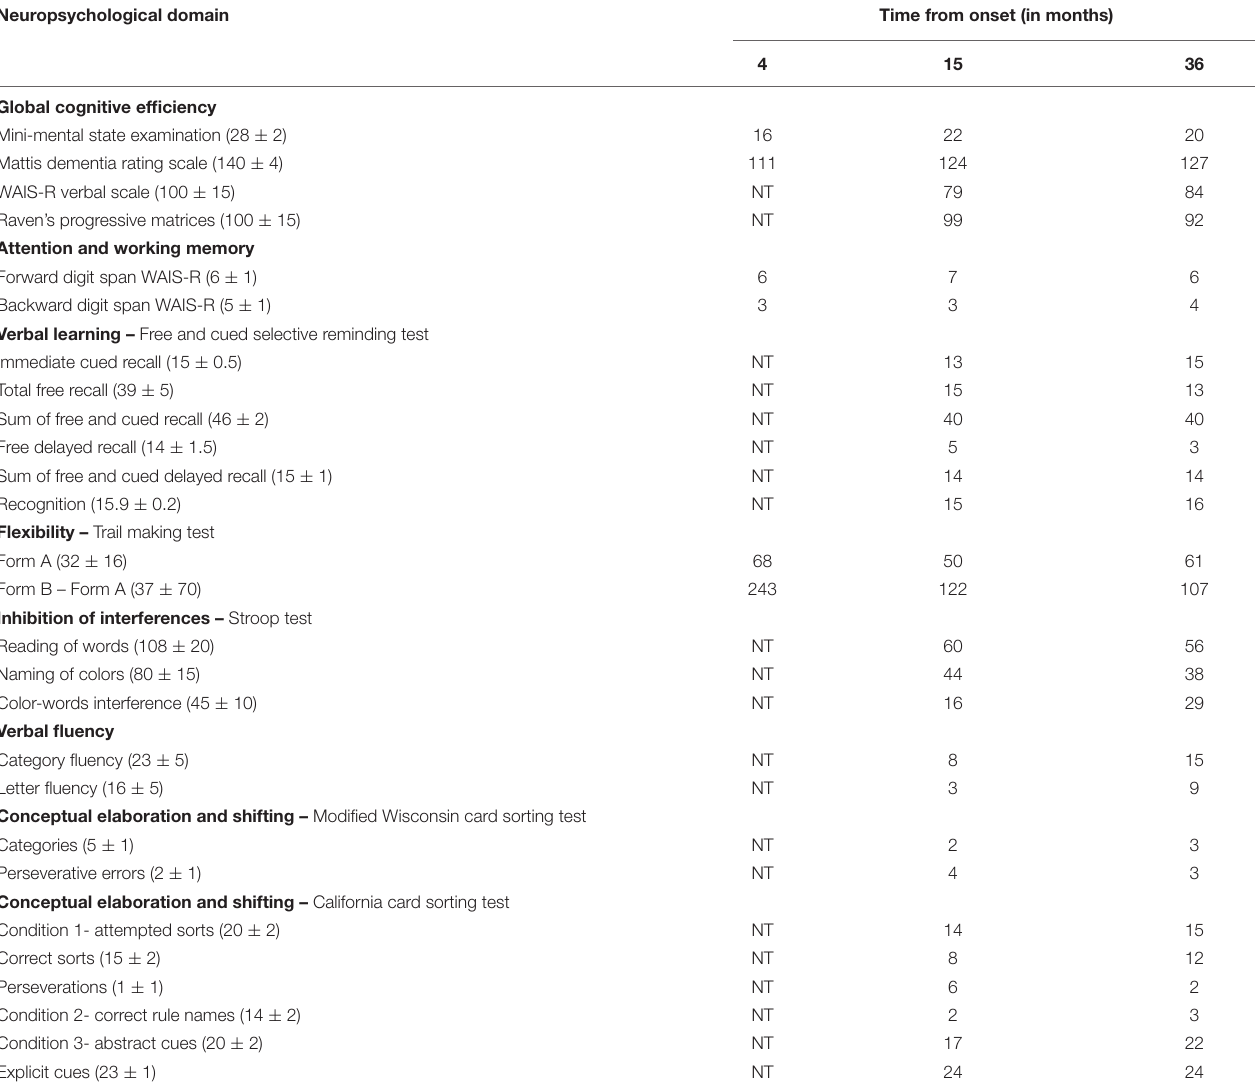
TABLE 1 | Results of neuropsychological evaluation performed at months 4, 15, and 36 from onset. Neuropsychological